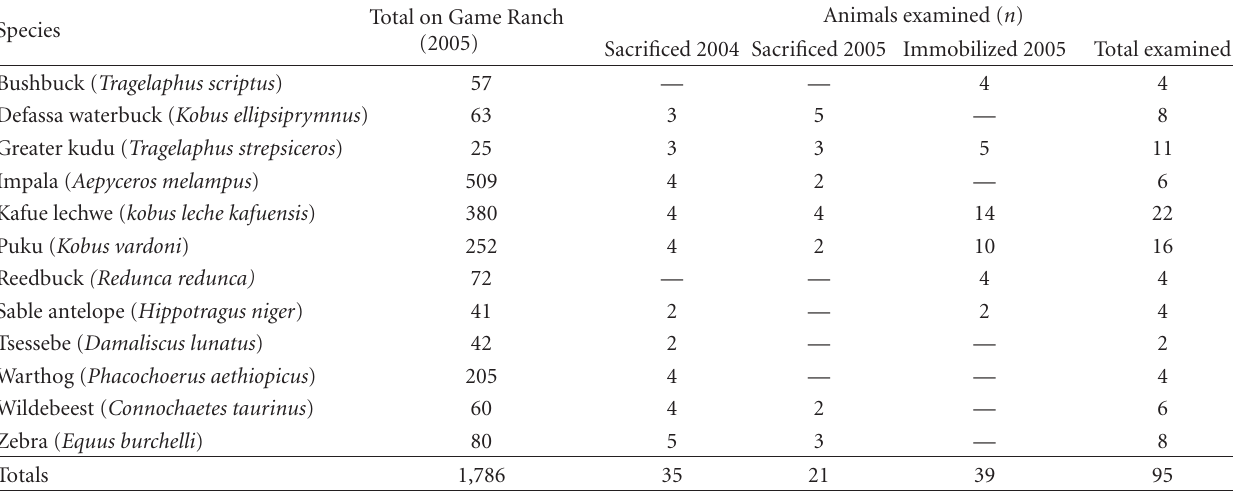
Table 1: Totals on the game ranch and number examined.